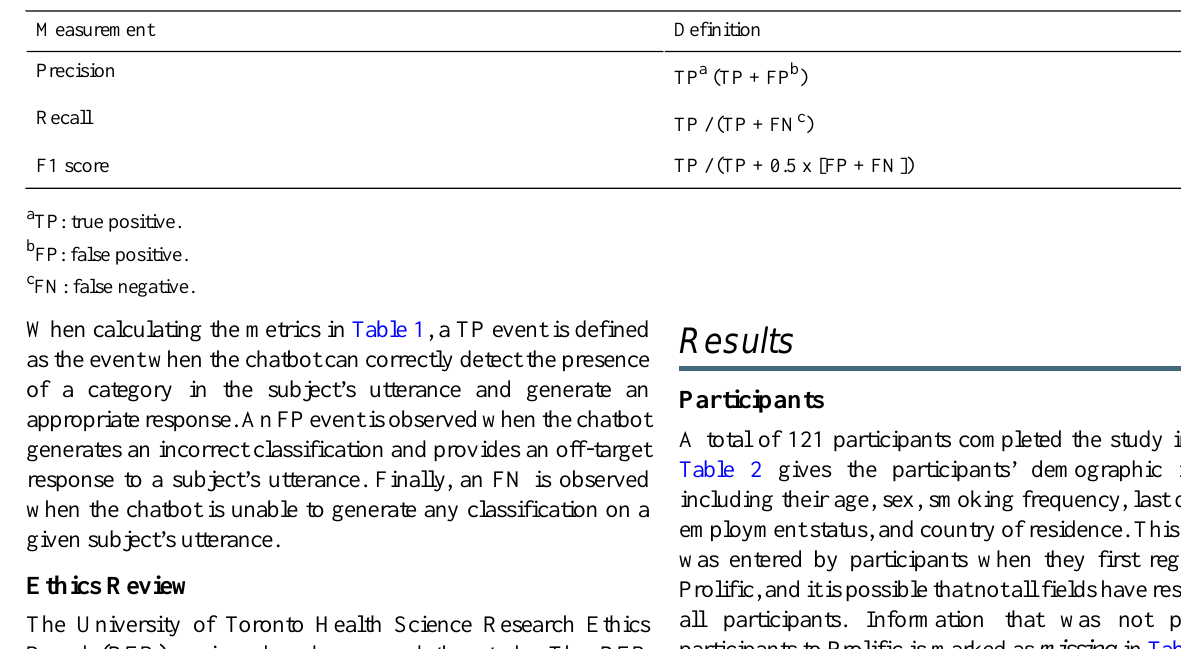
Table 1. Definitions of precision, recall, and F1